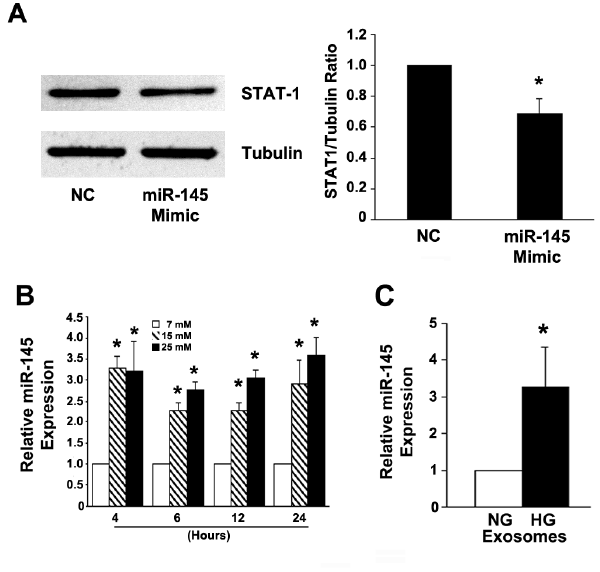
Figure 2. Expression of miR-145 in human mesangial cells. ( A ) Expression of STAT-1, a known miR-145 target, was assessed by immunoblotting in total protein extracts from mesangial cells transfected with either miR-145 mimic or scramble oligonucleotides. Tubulin was used as loading control. Results are depicted in the graph (*p<0.05) and a representative immunoblot is shown. ( B ) Human mesangial cells were exposed to increasing (6.8, 15, and 25 mM) glucose concentrations for 4,6,12 and 24 hours. Total RNA was extracted and levels of miR-145 measured by qRT-PCR (*p<0.01) 15 and 25 mM glucose vs. 6.8 mM glucose at all time points). ( C ) Human mesangial cells were exposed to either normal (6.8 mM-NG) or high (25 mM-HG) glucose concentrations for 24 hours. Exosomes were isolated from the supernatants by ultracentrifugation as described in the Methods. Total RNA was extracted and levels of miR-145 measured by qRT-PCR (*p<0.001 HG vs. NG). doi: